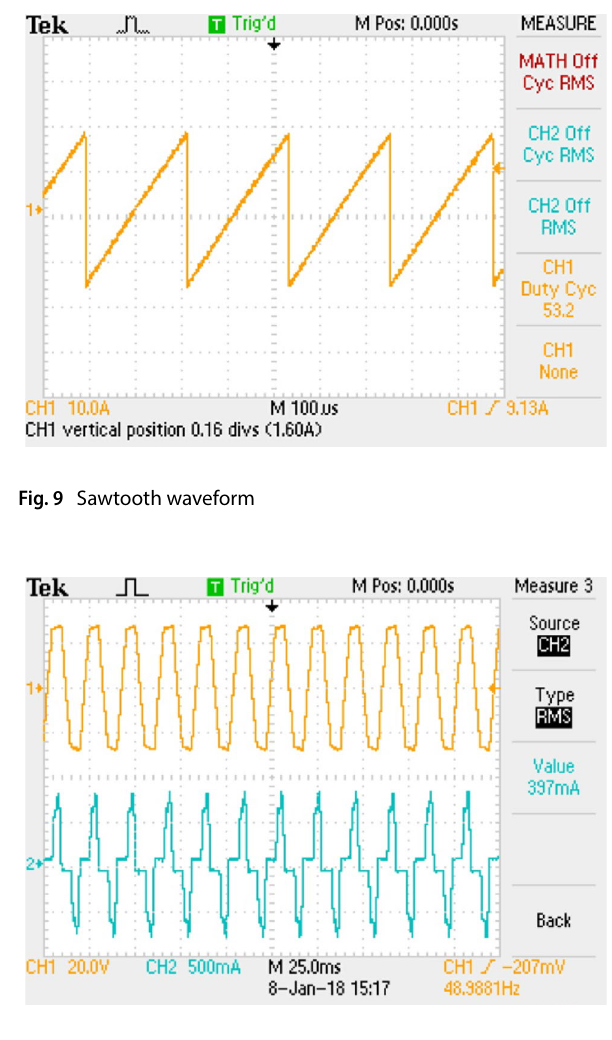
Fig. 10 Top: Single-phase voltage fed to EGLC (228 V) at zero con- sumer loads, Bottom: Current flowing through EGLC at zero con- sumer loads